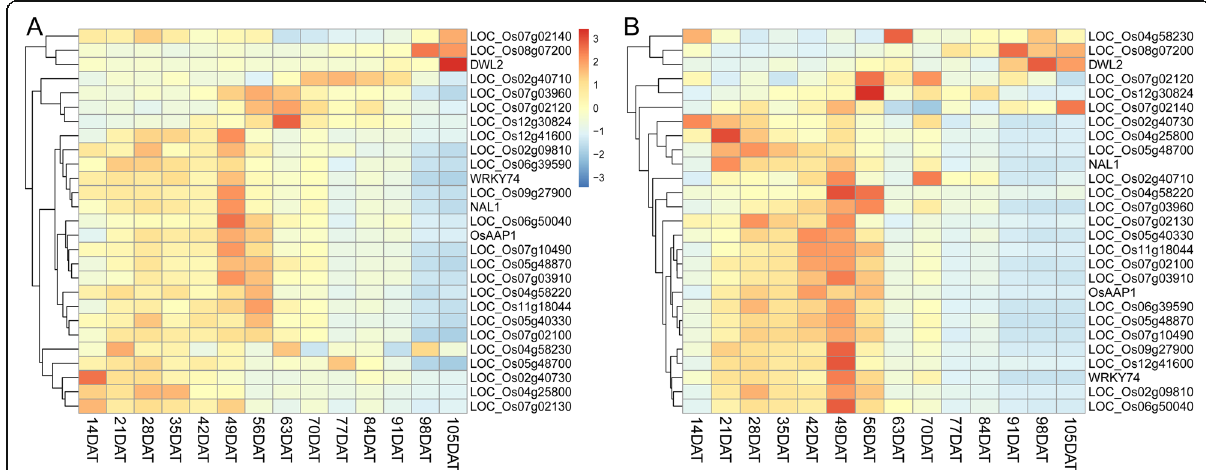
Fig. 6 Temporal expression pattern of ETN-associated genes during the whole growth period. Expression data in root at 00:00 ( a ) and 12:00 ( b ) were downloaded from RiceXPro website (https://ricexpro.dna.affrc.go.jp/). The heatmaps represented hierarchical clustering of relative expression levels of 27 candidate genes at different days after transplanting (DAT). The scale for relative expression levels (after normalized by z-score) is denoted by color bars, with red representing the high expression levels, white medium expression and blue low